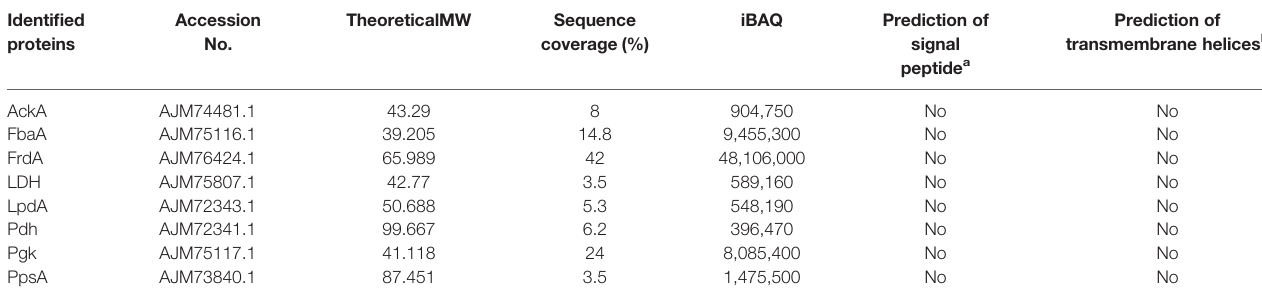
TABLE 3 | Identi fi cation of CMEs by LC-MS/MS and bioinformatics analysis. Identi fi ed Accession proteins